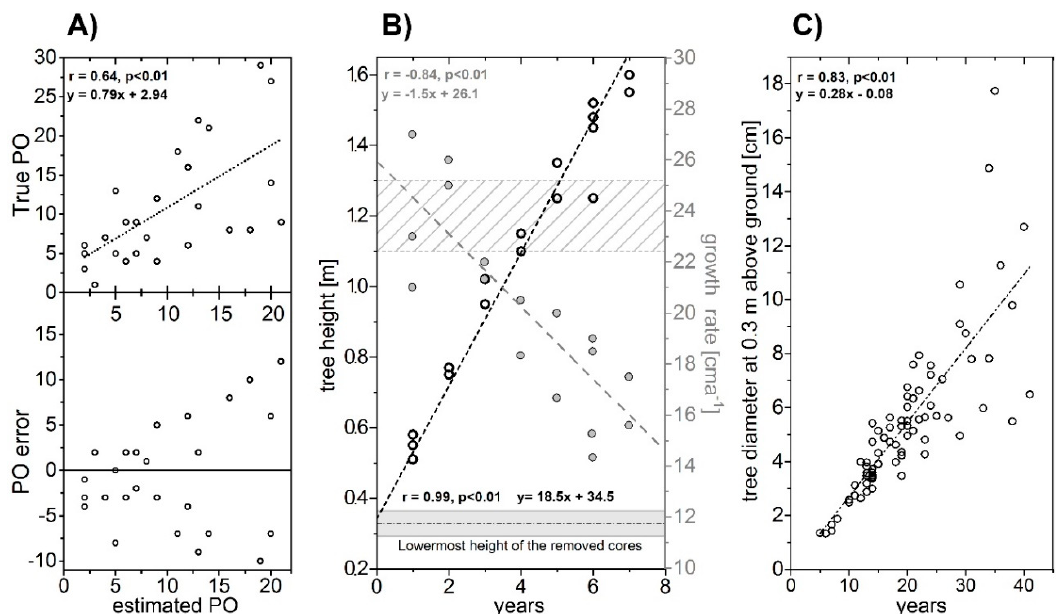
Figure 4. ( A ) Scatter plot of the estimated pith offset (PO) in relation to the true PO (upper panel) and the PO error (lower panel). ( B ) Tree height in dependence of the counted tree-rings and resulting growth rate. The grey shaded area displays the lowermost coring elevation on the lateral moraine, the grey hatched area indicates coring height on the terminal moraine system. ( C ) Graph comparing increasing trunk diameter respective to tree age for trees sampled on the lateral moraine.